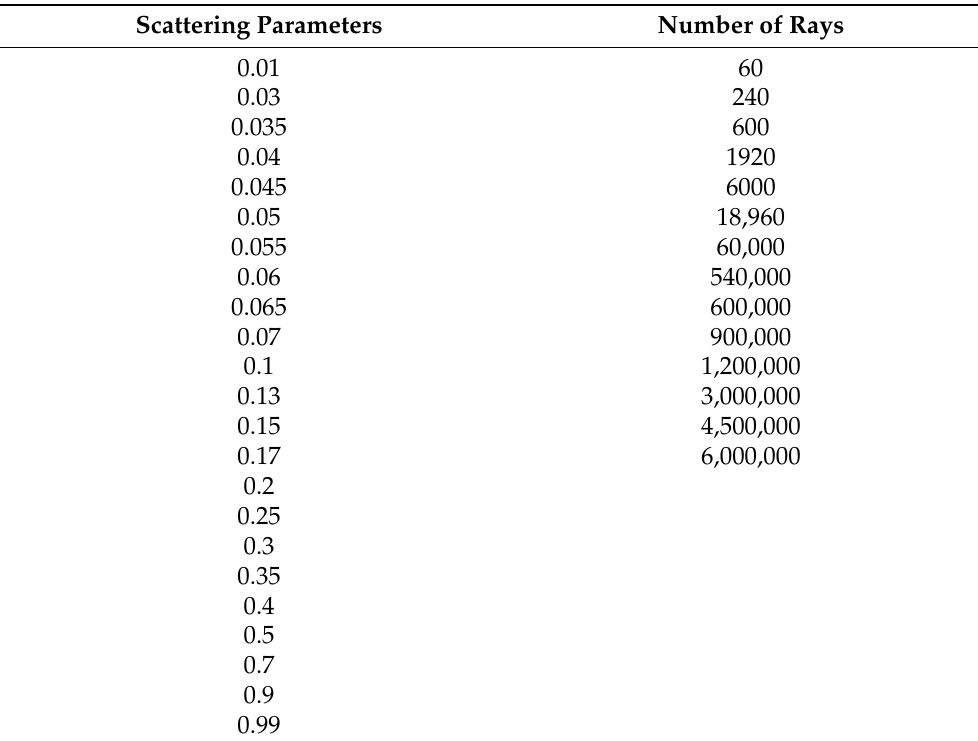
Table 2. The range of scattering values and number of rays used for simulations. In total, 23 different scattering parameters and 14 different numbers of rays were